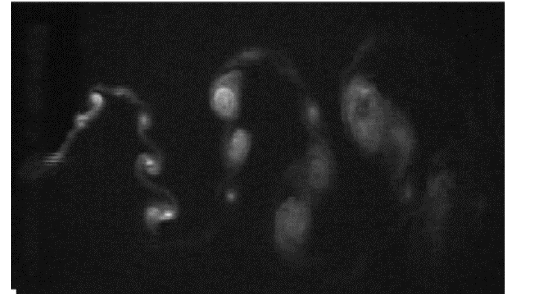
Figure 10. Vorticity pattern visualized in the foil wake, for St = 0.45, a max = 20°.